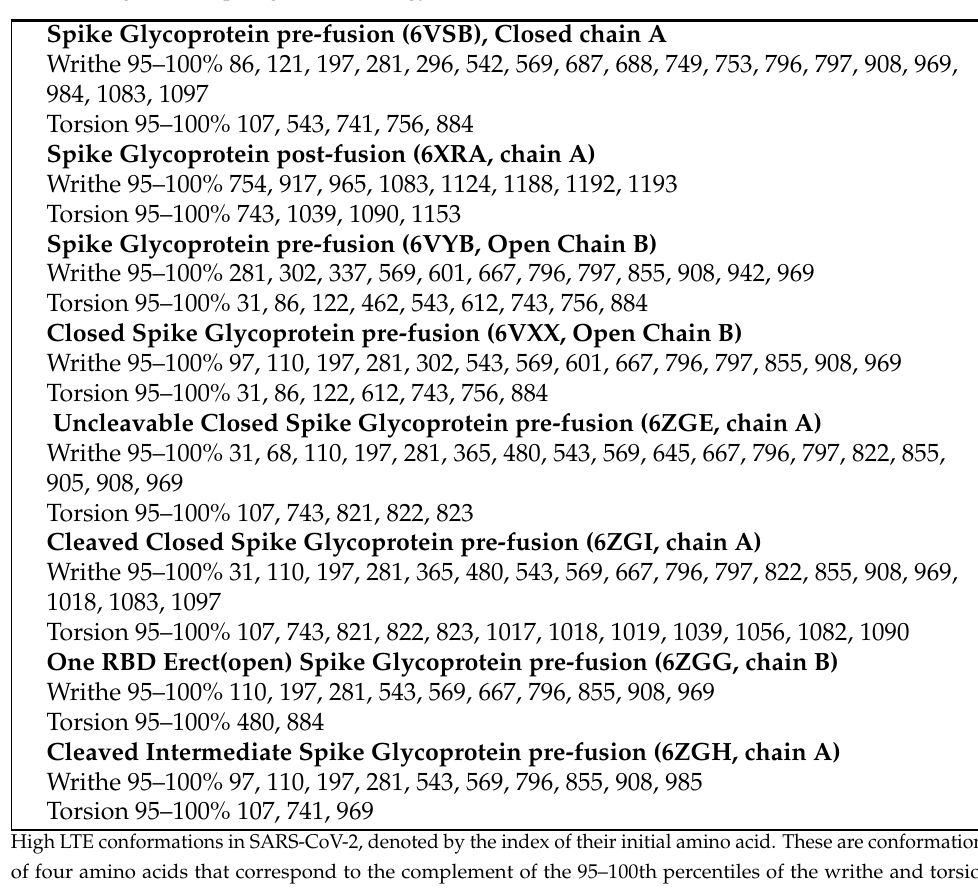
Figure 6. High LTE conformation proportions. We find a disproportional number of mutations of interest occur in high LTE conformations. Namely, only 8% of local conformations in SARS-CoV-2 have high LTE. However, 18% of mutations of interest occur in high LTE conformations. Out of all the mutations in the omicron variant, 22% are in a high LTE conformation. Table 1. High local topological free energy conformations of SARS-CoV-2